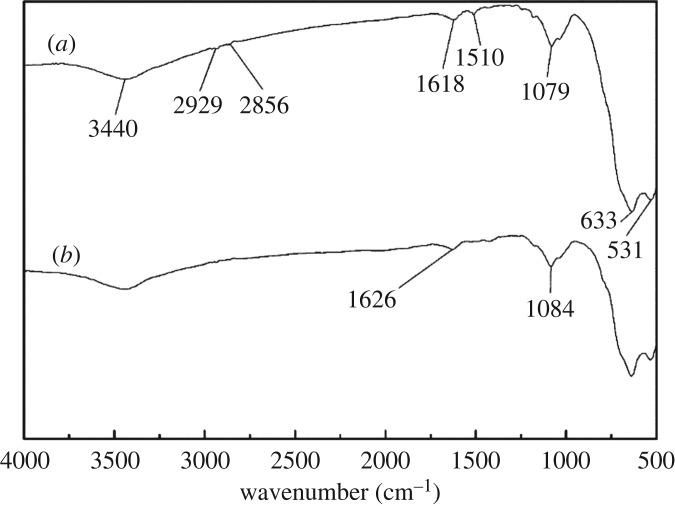
Effect of Ca2+ on the adsorption of OHA on cassiterite: (a) cassiterite conditioned in OHA at a pH of 9.0; (b) cassiterite conditioned in Ca2+ and OHA.